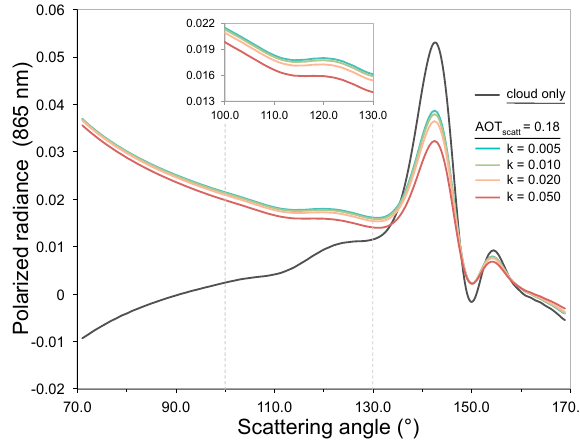
Figure 2. Simulated polarized radiance at 865nm plotted against the scattering angle. Black line corresponds to the cloud only (COT = 10, r eff = 10µm). Colored lines are for an above-cloud aerosol layer. The effective radius of aerosols is 0.10µm. Several absorption AOT values (i.e., various k ) have been considered but the scattering AOT is fixed at 0.18. The inset focuses on polarized radiances of aerosols above clouds for scattering angles between 100 and 130 ◦ . Complementary information about vertical distribu- tions and properties of aerosols and clouds can be found in Table 1 (see polarized look up table